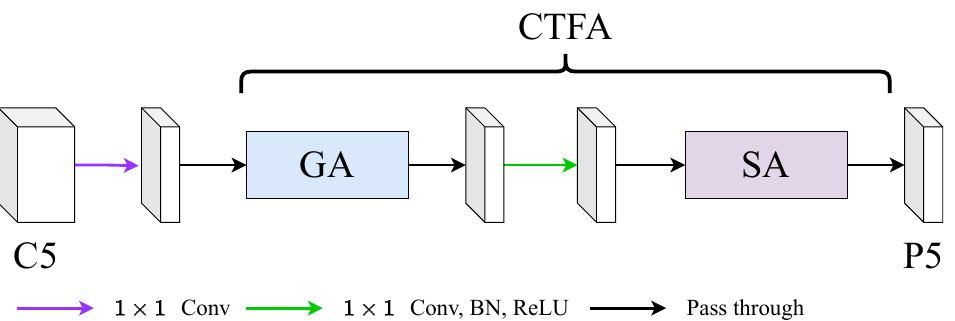
Figure 2. An illustration of coarse-to-fine attention (CTFA). CTFA consisted of a global-modelling attention (GA) and a scale attention (SA). GA was aimed at capturing long-range relationships and SA was aimed at reweighting with local